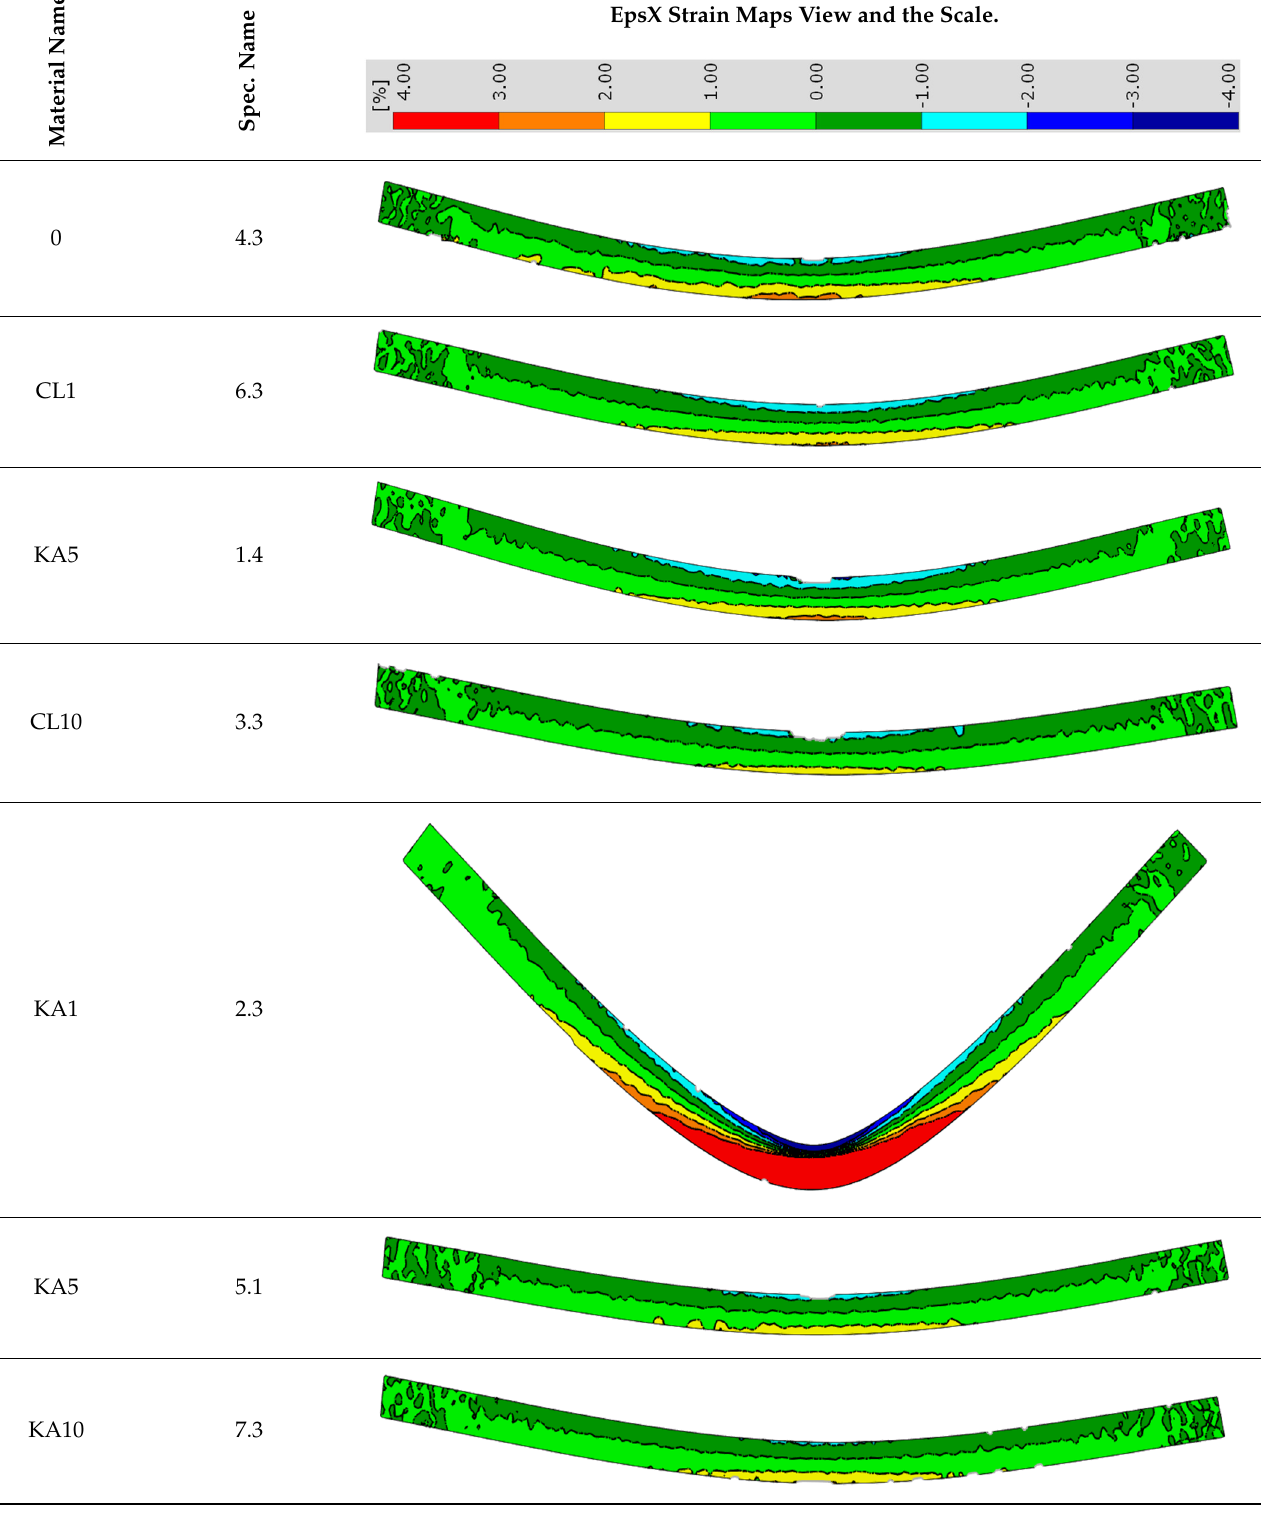
bending stress vs. bending stress vs. deformation.